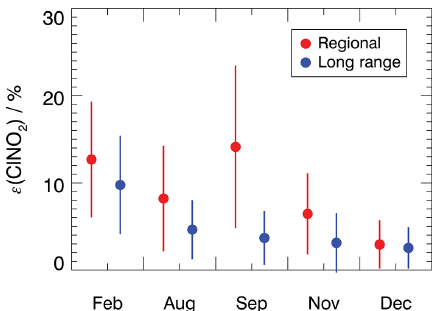
Figure 5. Mean ClNO 2 production efficiency for each measure- ment period for 4h average values starting after sunset. Values are calculated for air masses originating either from regional or long- range transportation. The vertical bars denote 1 σ standard devia-